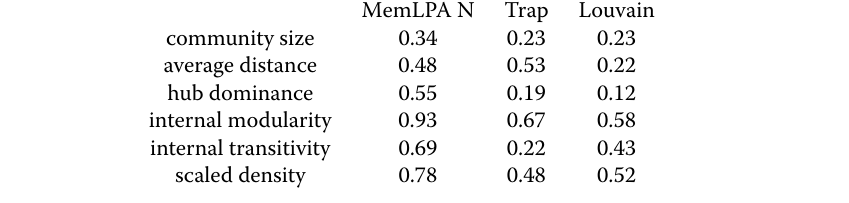
Fig. 9 Experiments on the LFR benchmark. N: node preference. Experiments are run 500 times and results averaged on communities having same size. The KS distance between the ground truth and communities found is shown in the table